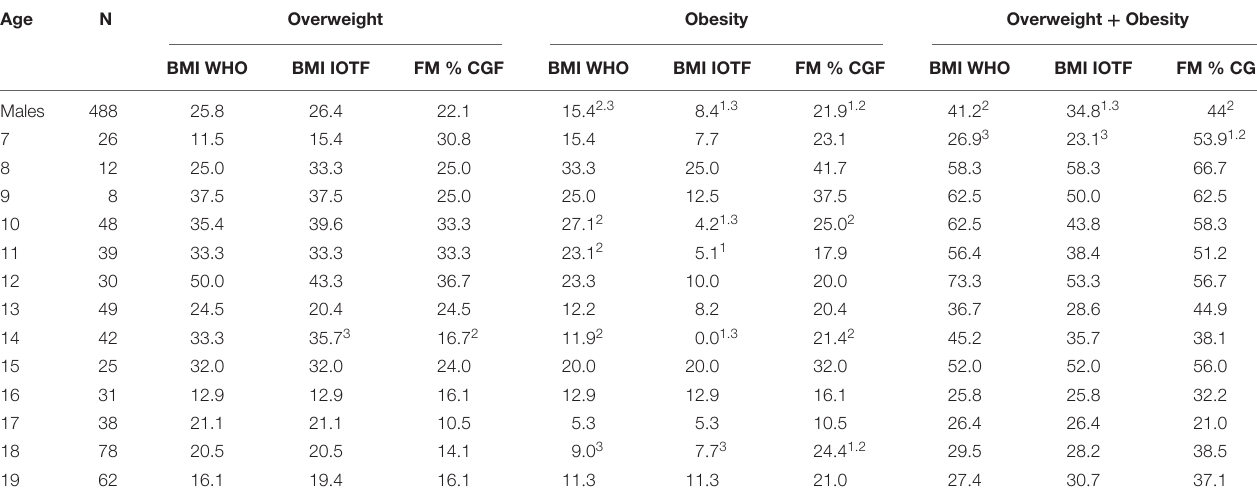
TABLE 3 | Prevalence (%) of overweight and obesity of males by age ( N = 488). Age N